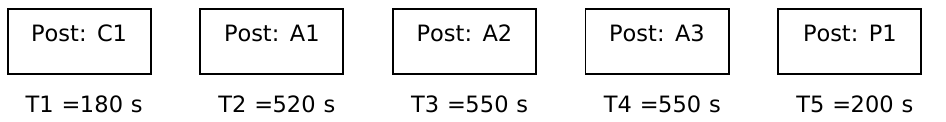
Figure 1. “Cycle time for every work post before the line balancing”.